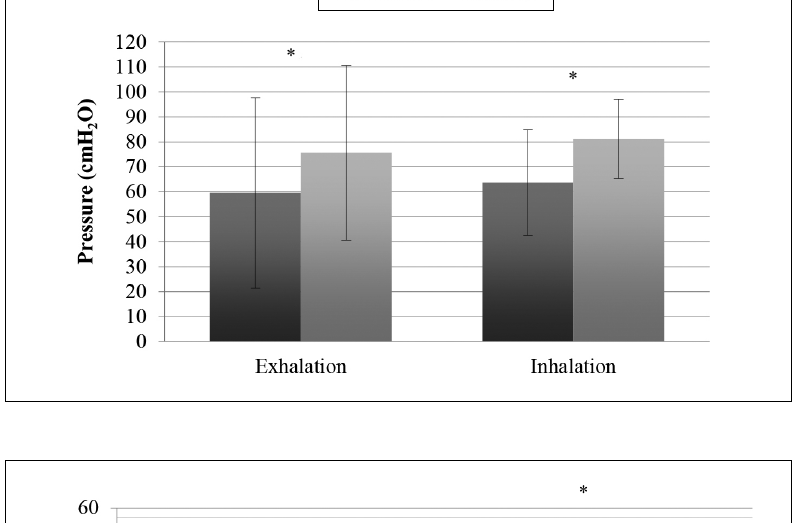
Figure 3. Abdominal muscle endurance change before and after physical therapy